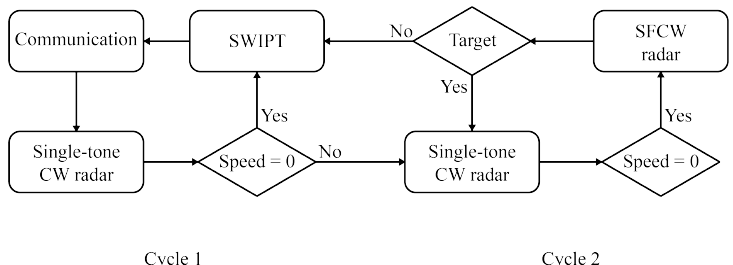
Figure 2. Assignment of three modes at the base